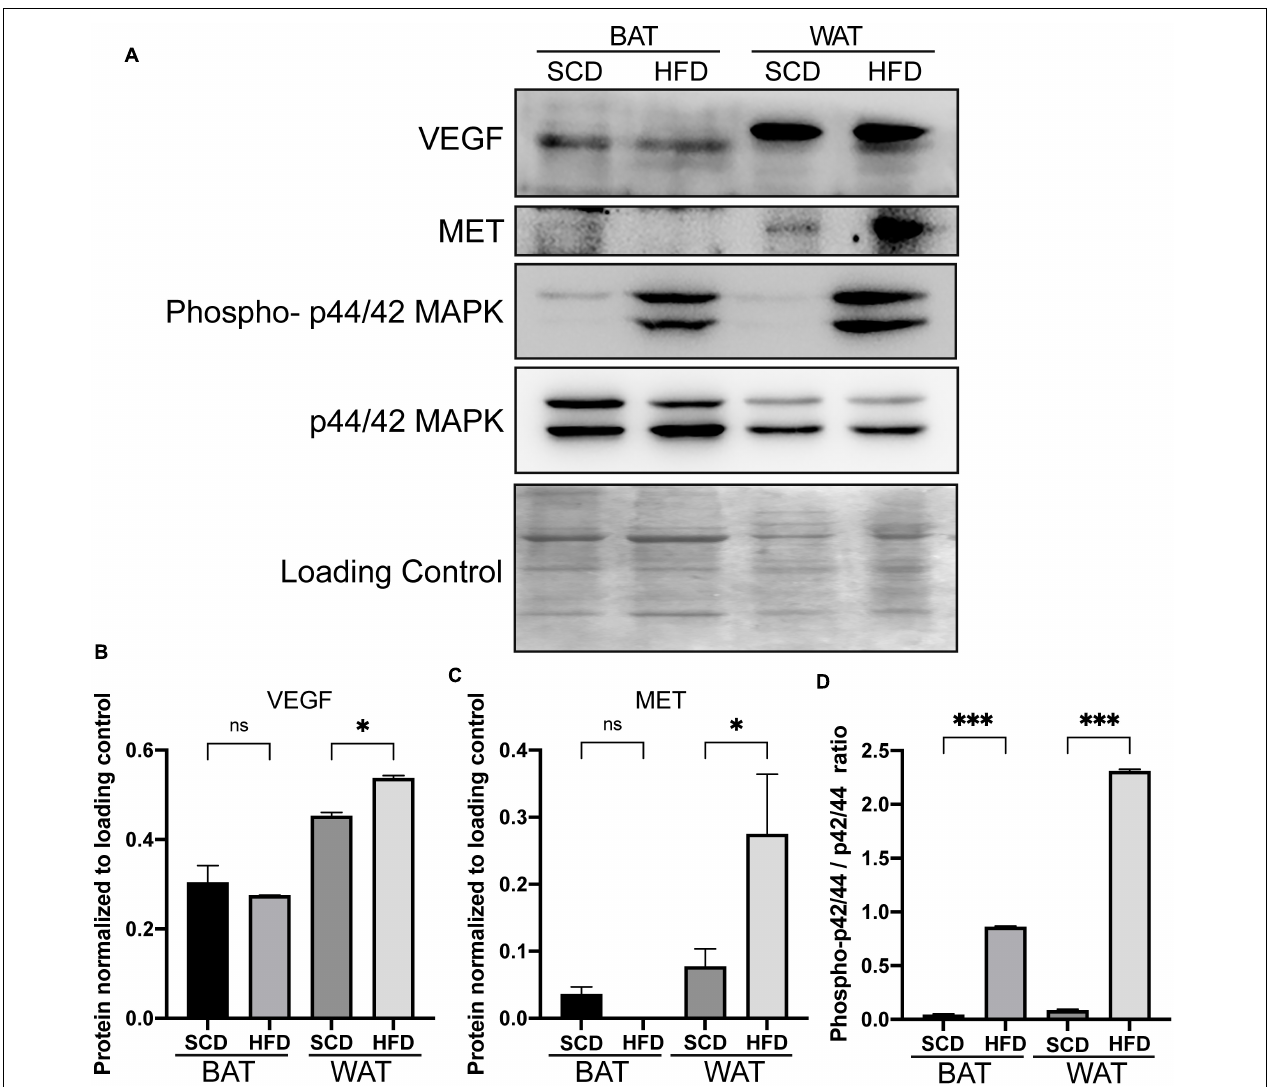
FIGURE 6 | Increased expressions of genes in the adipose tissue of rats under HFD conditions by western blot analysis. Western blot analysis of the increased expressions of Met and Vegfa gene and the enhanced ratio of phosphorylation of p44/42 MAPK in adipose tissues from HFD rat. (A) The protein expression of Met, Vegfa and phospho-p44/42 MAPK in the adipose tissue of rats. (B–D) Bar plot of the statistical significance of Met and Vegfa expression and phosphorylation-p44/42 MAPK ratio in HFD and SCD adipose tissues in rat by unpaired student’s t tests. Bars represent standard errors. ∗ , ∗∗ , and ∗∗∗ indicates P- value < 0.05, 0.01, and 0.001, respectively. WAT, white adipose tissue; BAT, brown adipose